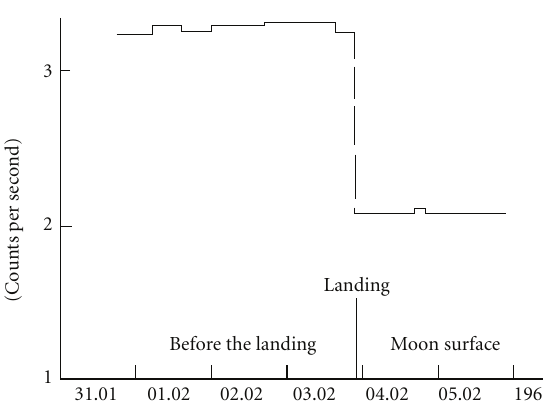
Figure5:Radiationfluxintheinterplanetaryspaceandonthelunar surface according to data of the gas-discharge counter onboard the station